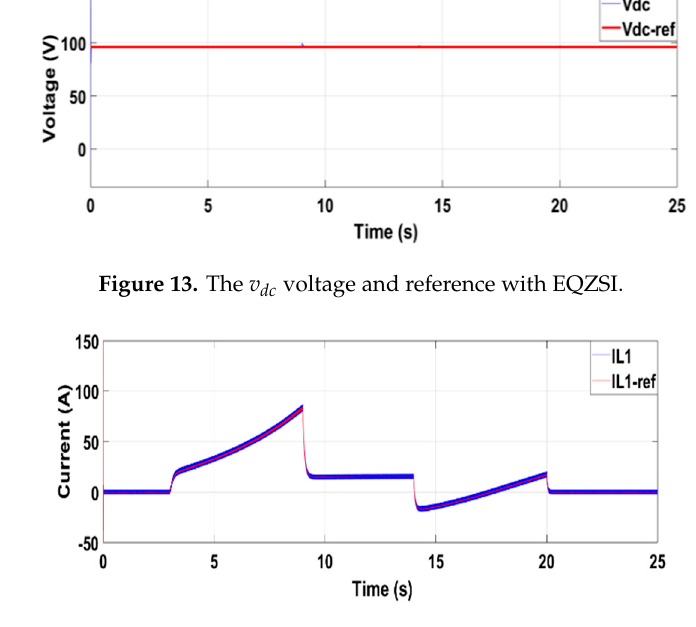
Figure 14. The i L 1 current and reference with